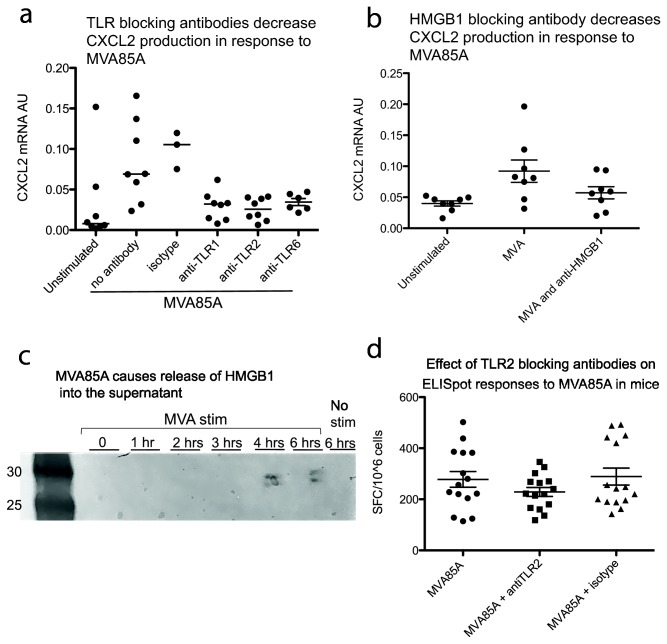
Toll-like receptors and HMGB1 in the innate response to MVA85A.A. Incubating PBMC with TLR blocking antibodies decreases CXCL2 production in response to MVA85A (Mann-Witney test for all 4 comparisons 0.01<p<0.05). B. Anti-HMGB1 also reduces CXCL2 production in response to MVA85A stimulation (Wilcoxon paired test, p<0.05). C. Western blot showing HMGB1 is released into the supernatant of MVA85A stimulated but not unstimulated cells. D. Mixing anti-TLR2 to MVA85A when vaccinating mice reduces the spread of responses (F-test, p<0.05) but not the mean (student’s t-test, p=0.18 MVA vs anti-TLR2, p=0.12 MVA85A vs isotype control).